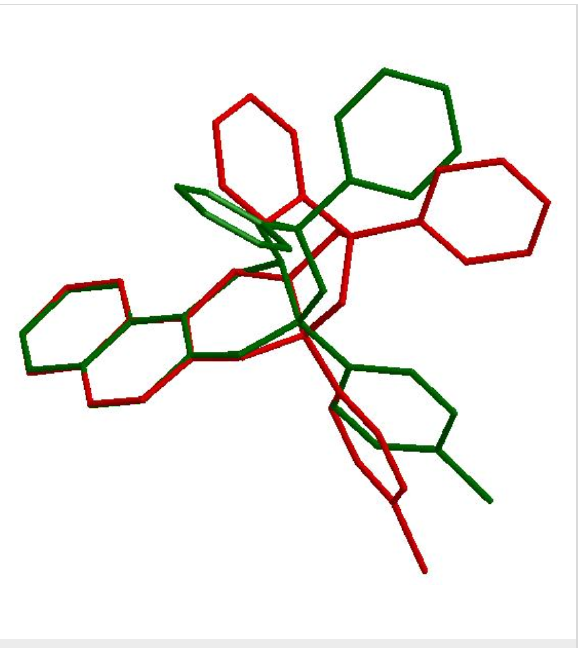
Figure 2: Superposition of the skeletons of boronate complexes 8 (red) and 10 (green).